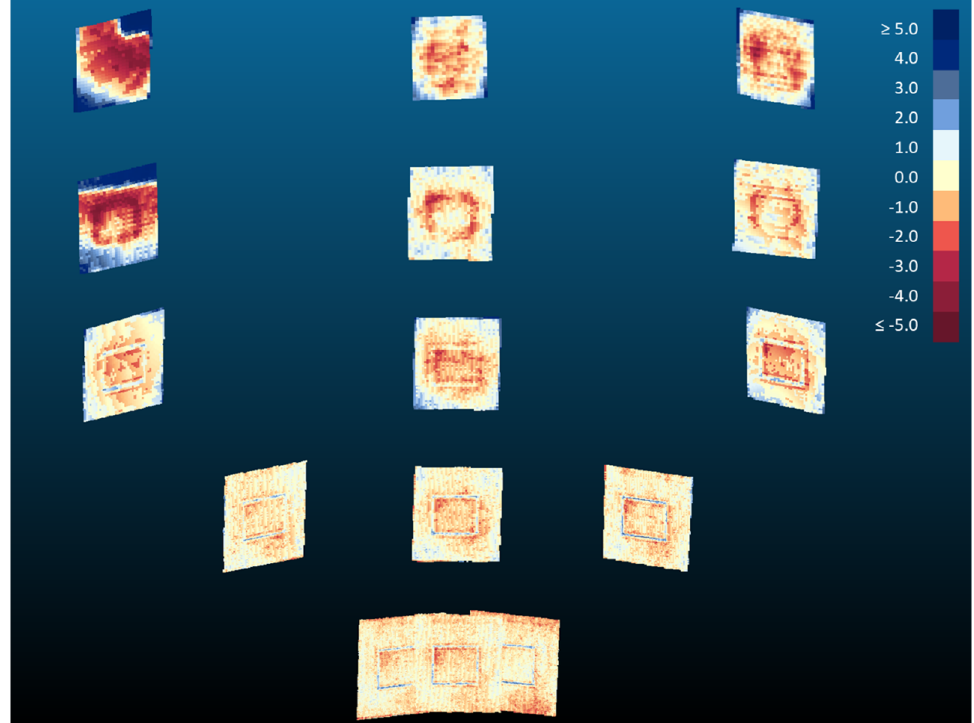
Figure 15. Color map distance plots of the averaged Kinect v2 point clouds to their planes of best fit. Distance values are in millimeters.